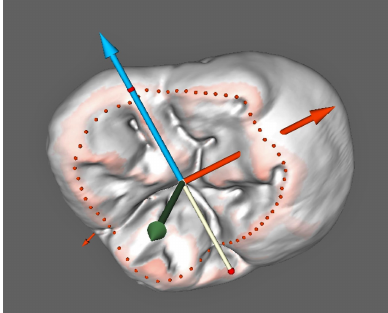
Figure 3. Orientation of axes on S2 upper right unerupted wisdom tooth enamel 3D reconstruction, 30-section mode.